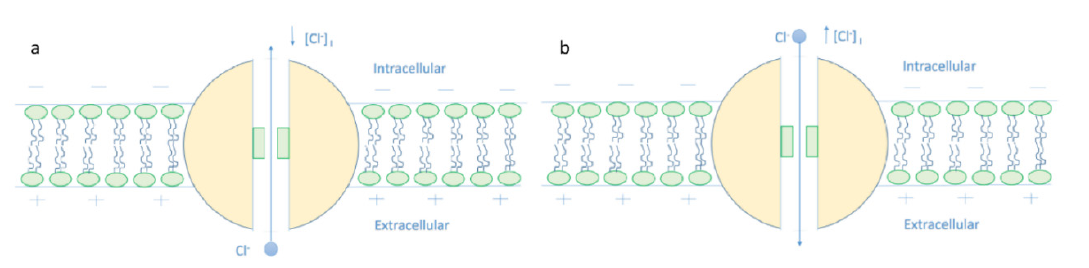
Figure 19. The figure represents the classical view that explains the depolarization action of GABA receptor. ( a ): The decrease in the intracellular chloride concentration will favor the influx of chloride ions that tends to hyperpolarize the membrane potential when the GABA receptor opens. ( b ): The increase in the concentration of the intracellular chloride ions will favor the efflux of chloride ions that tends to depolarize the resting membrane potential.